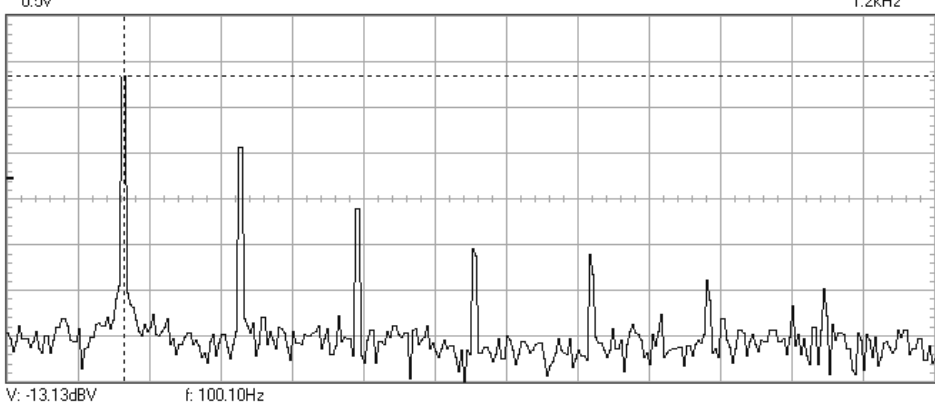
Figure 14. Amplitude spectrum recorded after 32,580 cycles at 108.6 Hz.